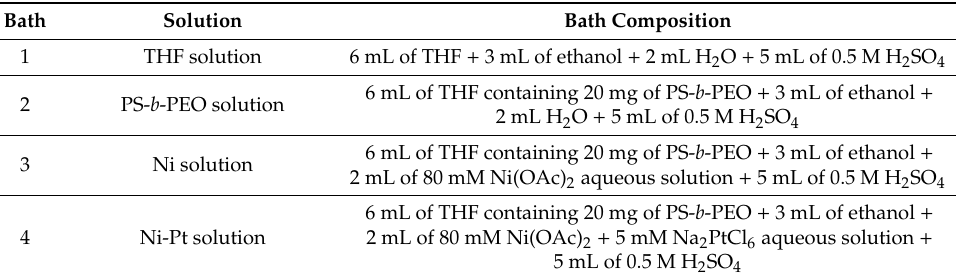
Scheme 1. Illustration of block copolymer micelles formation. Table 1. Electrochemical baths and bath Table 1. Electrochemical baths and bath composition.